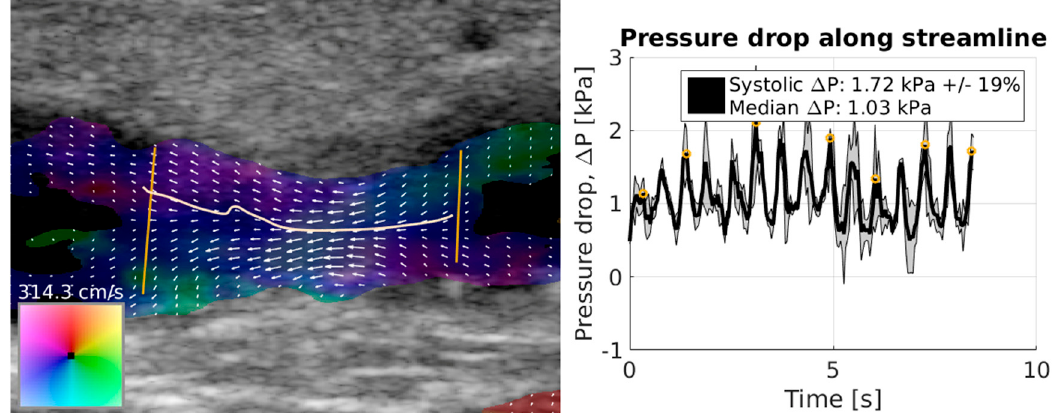
Figure 3. The left image shows vector velocity imaging of an arteriovenous fistula in a patient before intravascular balloon treatment of a stenosis. Arrows and colors represent the two-dimensional vector velocities as indicated by the color-box. Two vertical lines are manually placed, and a streamline representing the highest velocity between the two vertical lines is drawn. The right image shows the peak pressure gradient as a function of time along the plotted streamline over several heartbeats. Both the image and graph were created with an application provided by Jacob B. Olesen (BK Medical, Herlev, Denmark).